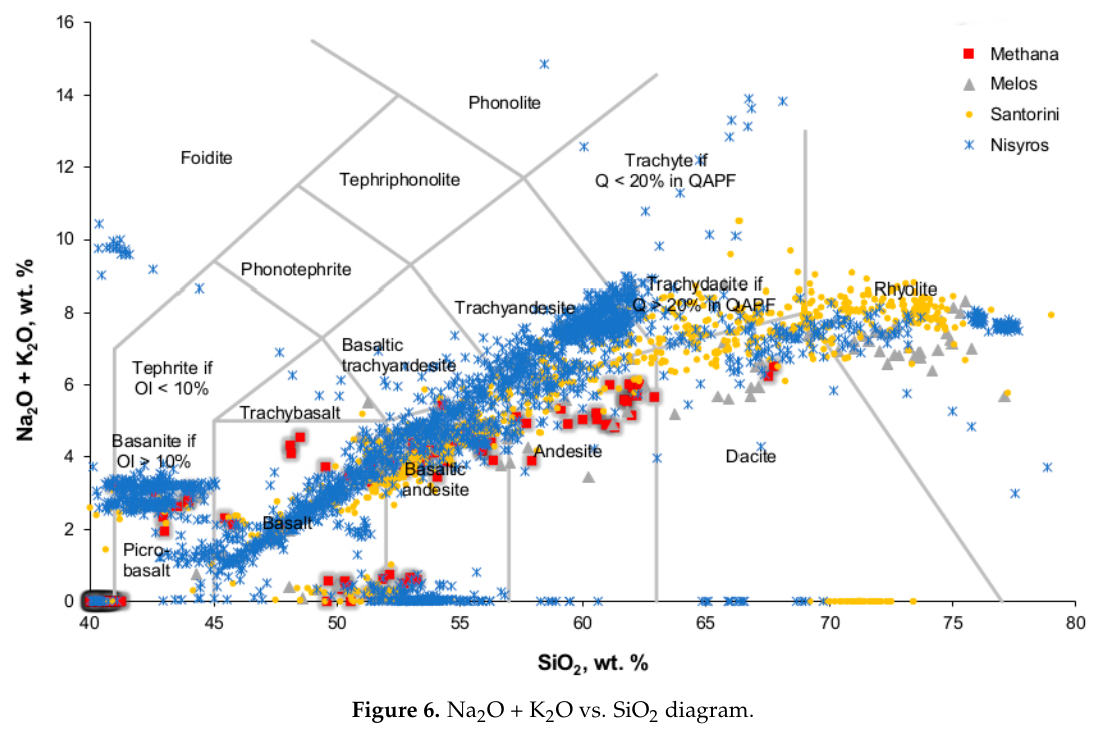
Figure 5. K2O vs. SiO2 diagram.